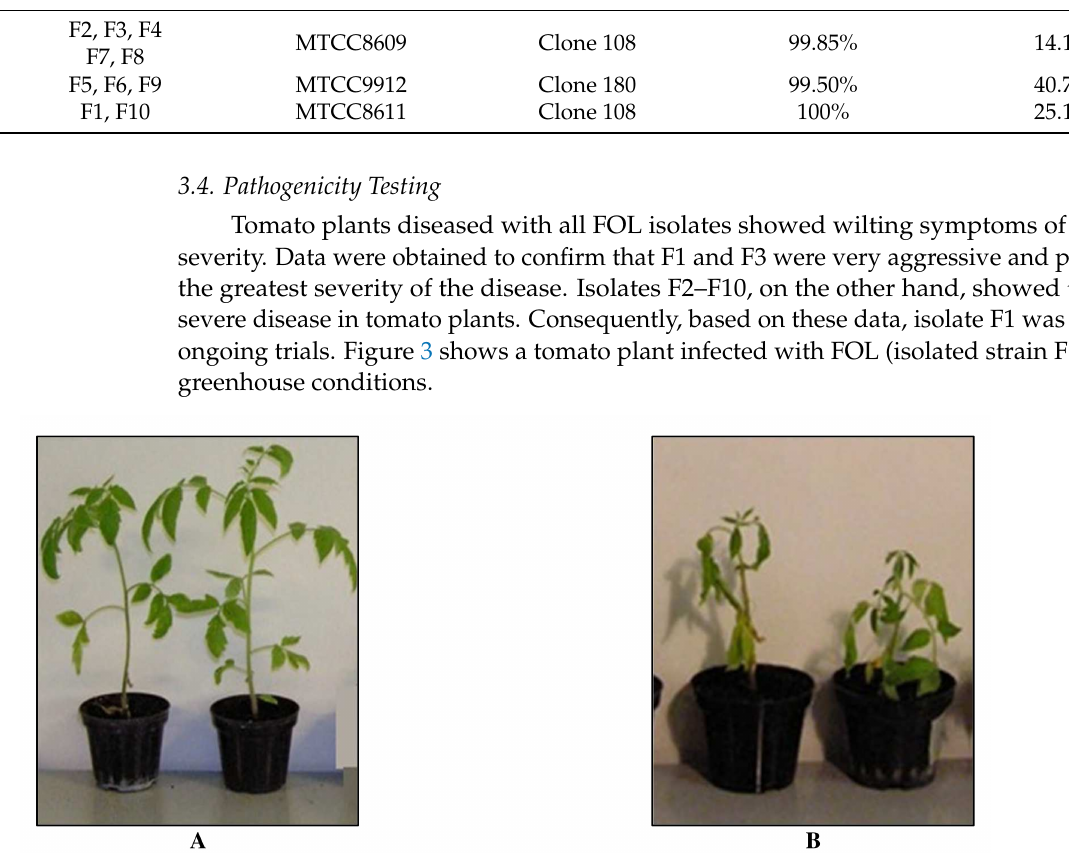
Figure 3. Pathogenicity test of tomato plant by FOL (Isolate F1) under greenhouse conditions. ( A ) Healthy tomato plants (control). ( B ) Infected tomato